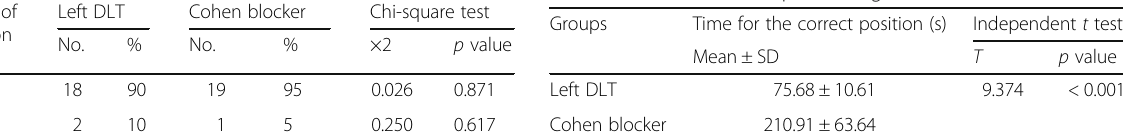
Table 3 Time for correct positioning